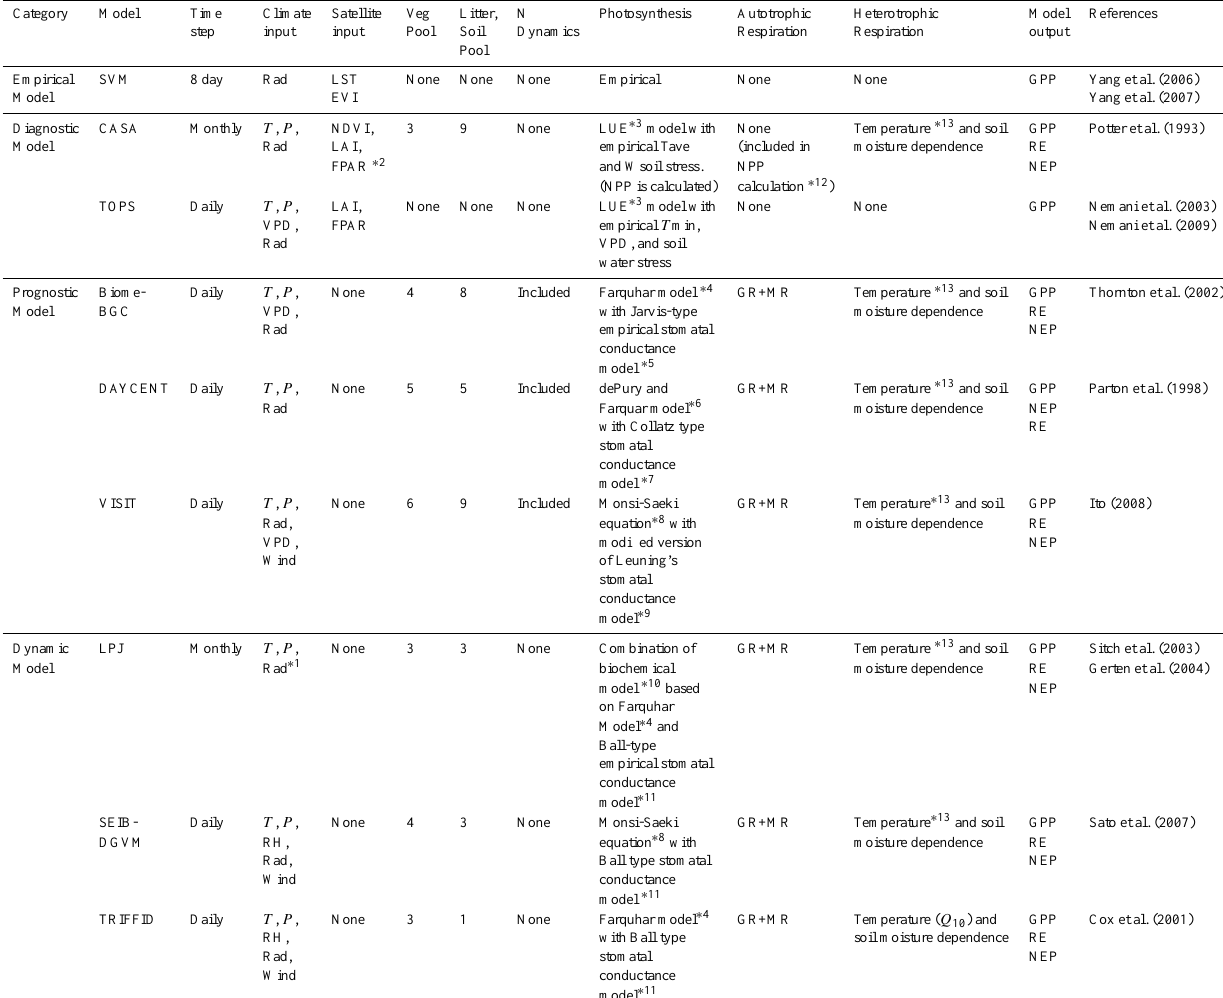
Table 2. Details for the terrestrial biosphere models used in this